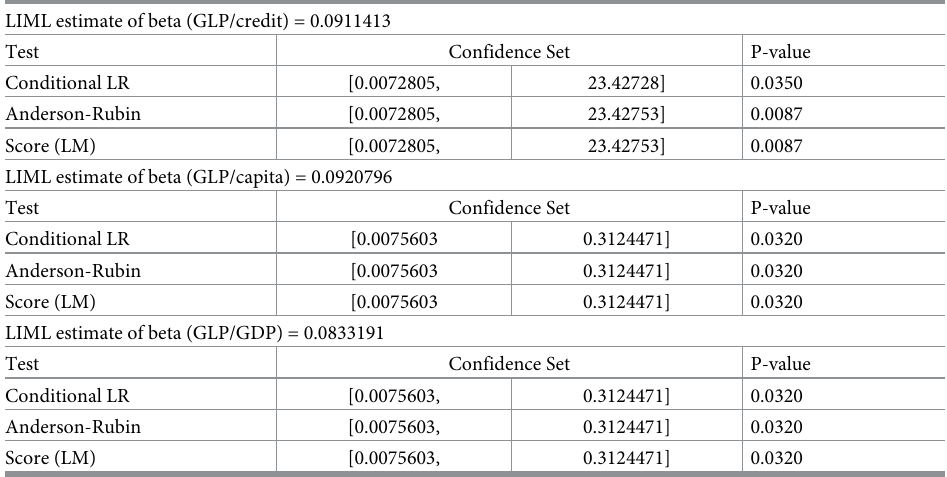
Table 8. Weak instrument-robust 2SLS (dependent: Distrust